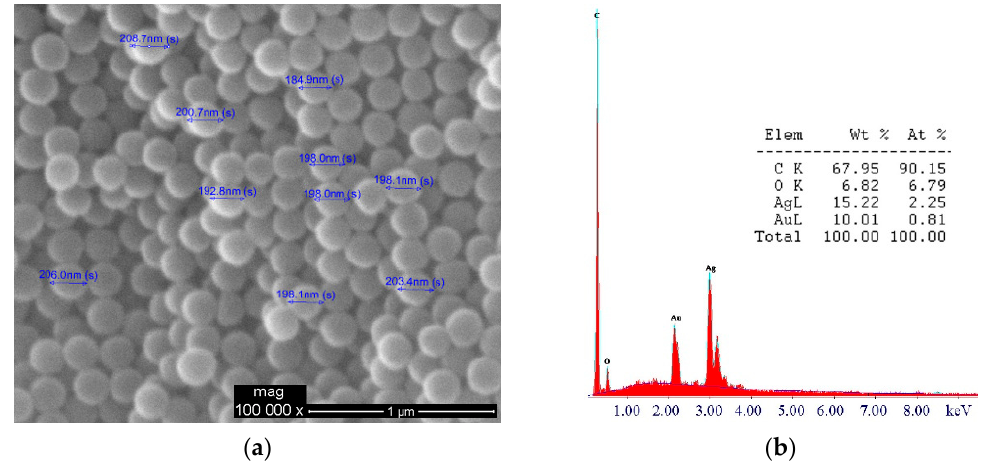
Figure 4. ( a ) SEM image of the P(MAA-co-MBA) microspheres; ( b )EDS analysis of the PMAA@Ag structures.